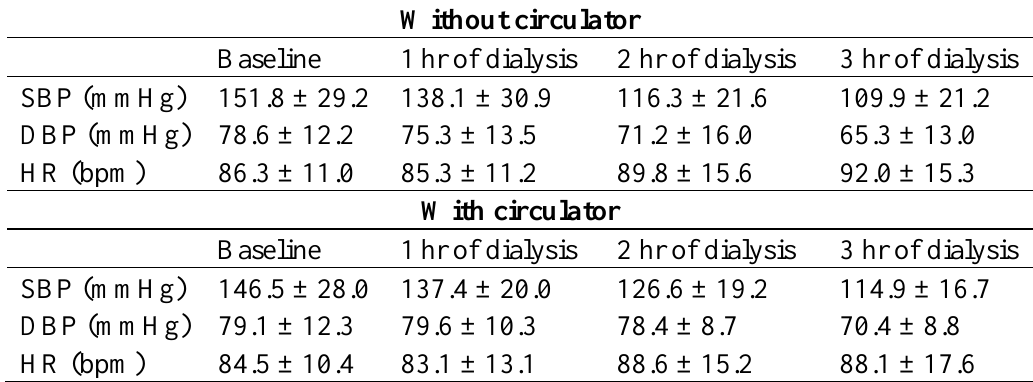
Table 1. Mean and standard deviation of SBP, DBP, and HR at different time points.